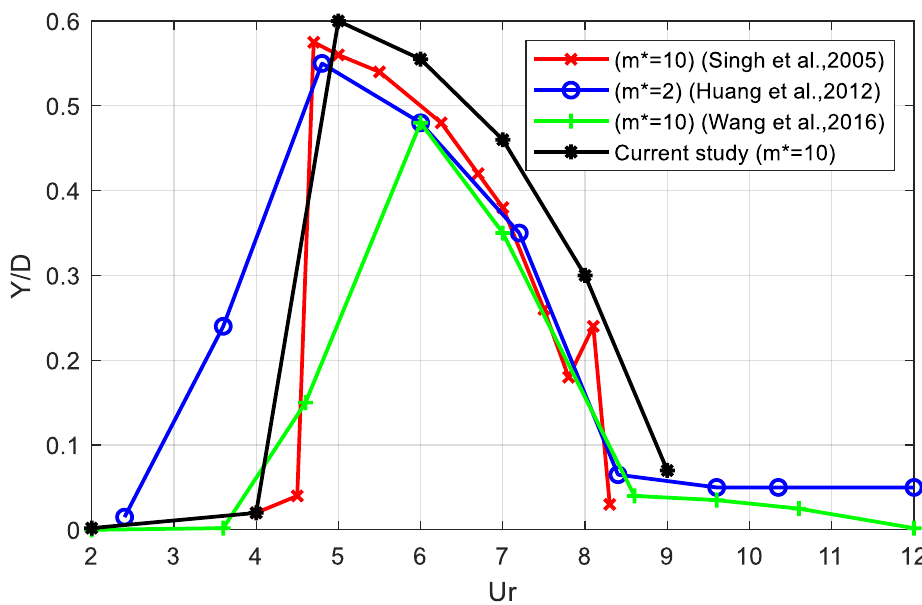
Figure 9. Comparison of the results of the simulations with those reported in the literature Singh et al. [26], Huang et al. [27], Wang et al. [28].